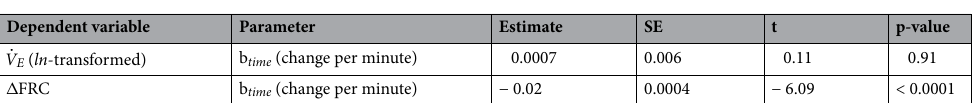
Table 4. Analysis of the change in breathing with time during the weighted prone phase W. Slope estimates per minute ( b time ) are provided from mixed-effect regression models that also account for a subject’s age and BMI as fixed effects, and subject identity as a random effect (n = 946 breaths from 17 subjects in the W phase). ˙ V E is ln